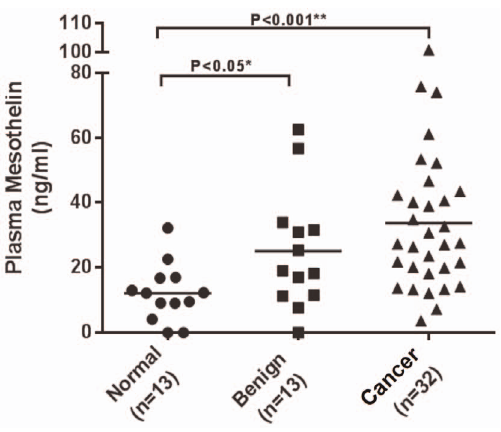
Figure 1. Plasma Mesothelin concentrations in different groups of patients. This figure shows plasma Mesothelin concentrations in pancreatic cancer patients (n=32), patients with benign pancreatic disease (n=13), or healthy controls (n = 13) detected using an ELISA assay for human Mesothelin. The horizontal line displays the median value for each group. Mann-Whitney U test was used to compare the levels of plasma Mesothelin in different groups of patients.